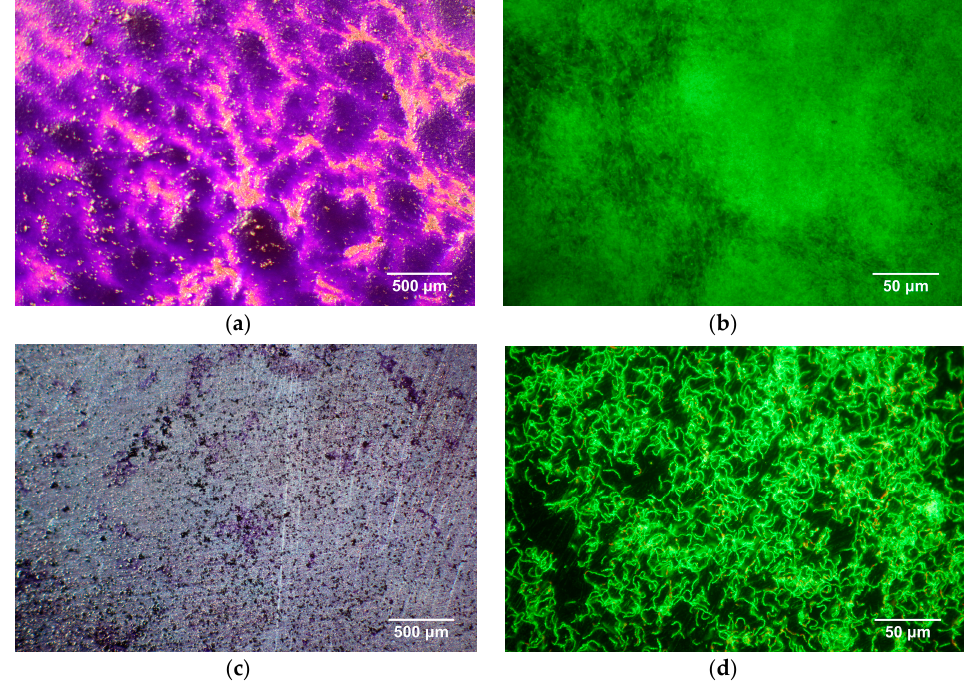
Figure 9. Biofilm formation and initial bacterial adhesion on Ti-6Al-4V alloy ( a , b ); and Zn-4Ag alloy ( c , d ) after incubation with S. gordonii for 12 h. Images obtained by: ( a , c ) crystal violet staining (magnification 32×); and ( b , d ) live/dead staining (magnification 400×).